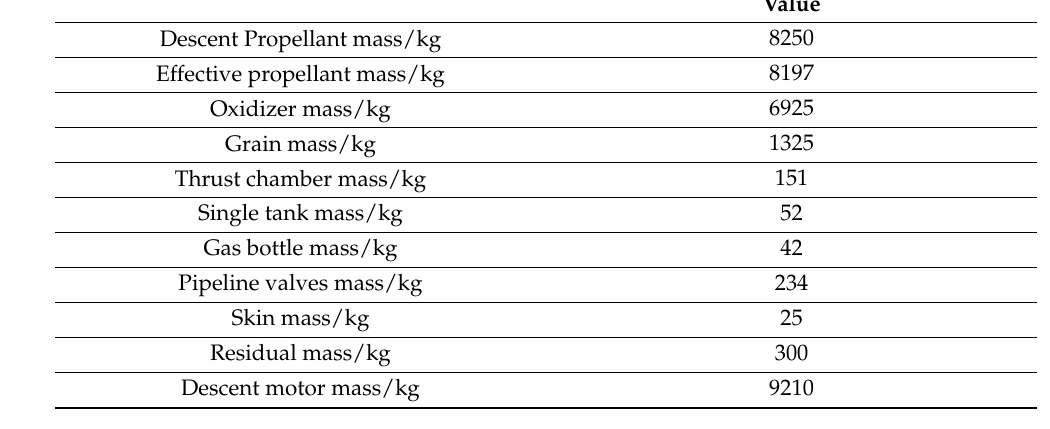
Figure 14. Weight distribution of each attribute.